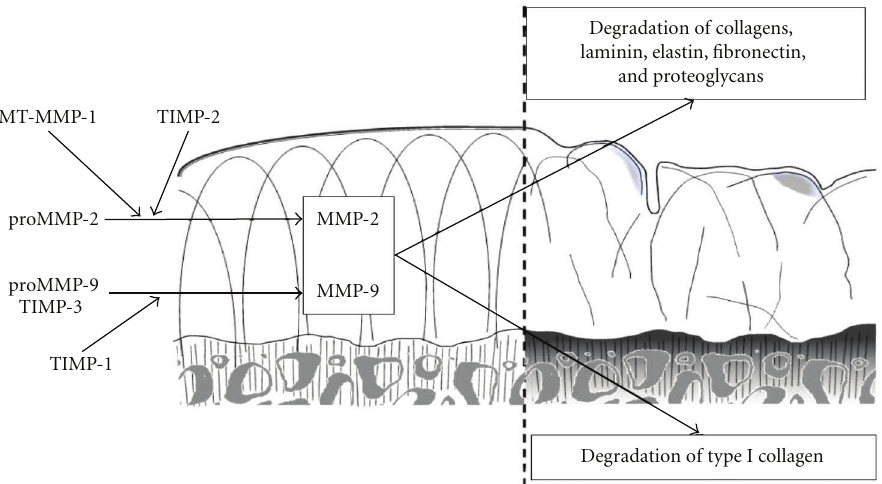
Figure 1: The activation of gelatinases and their activity during osteoarthritis. Normal (left) and osteoarthritic (right) cartilage and subchondral bone.